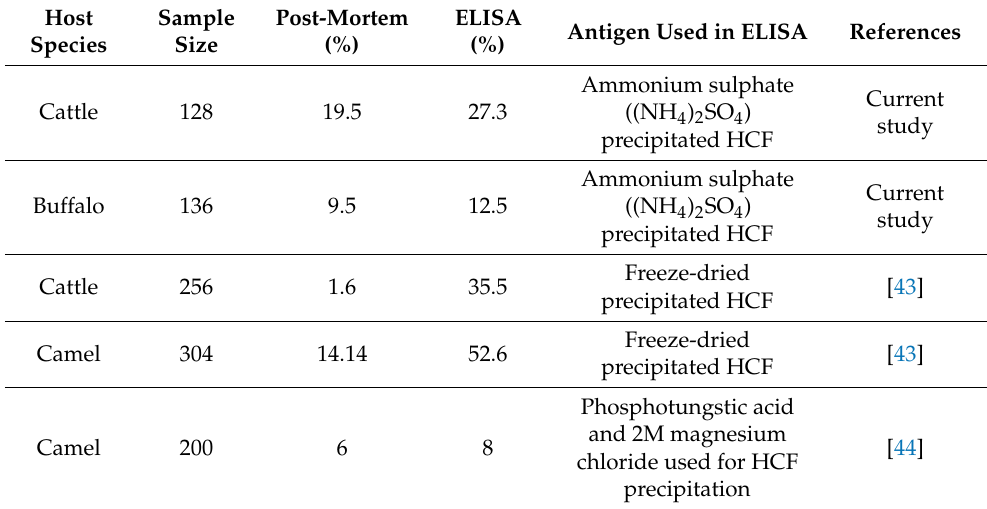
Table 4. Comparison of post-mortem and serological examination results among studies.